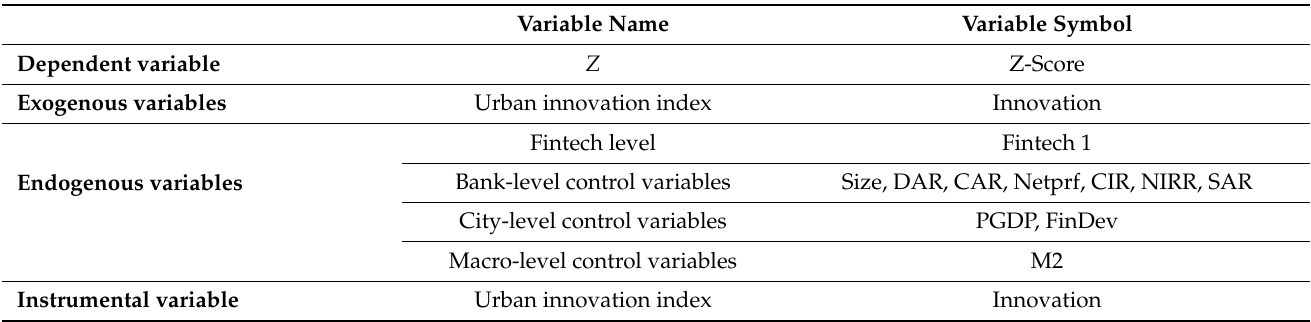
Table 4. Variable setting in 2SLS.